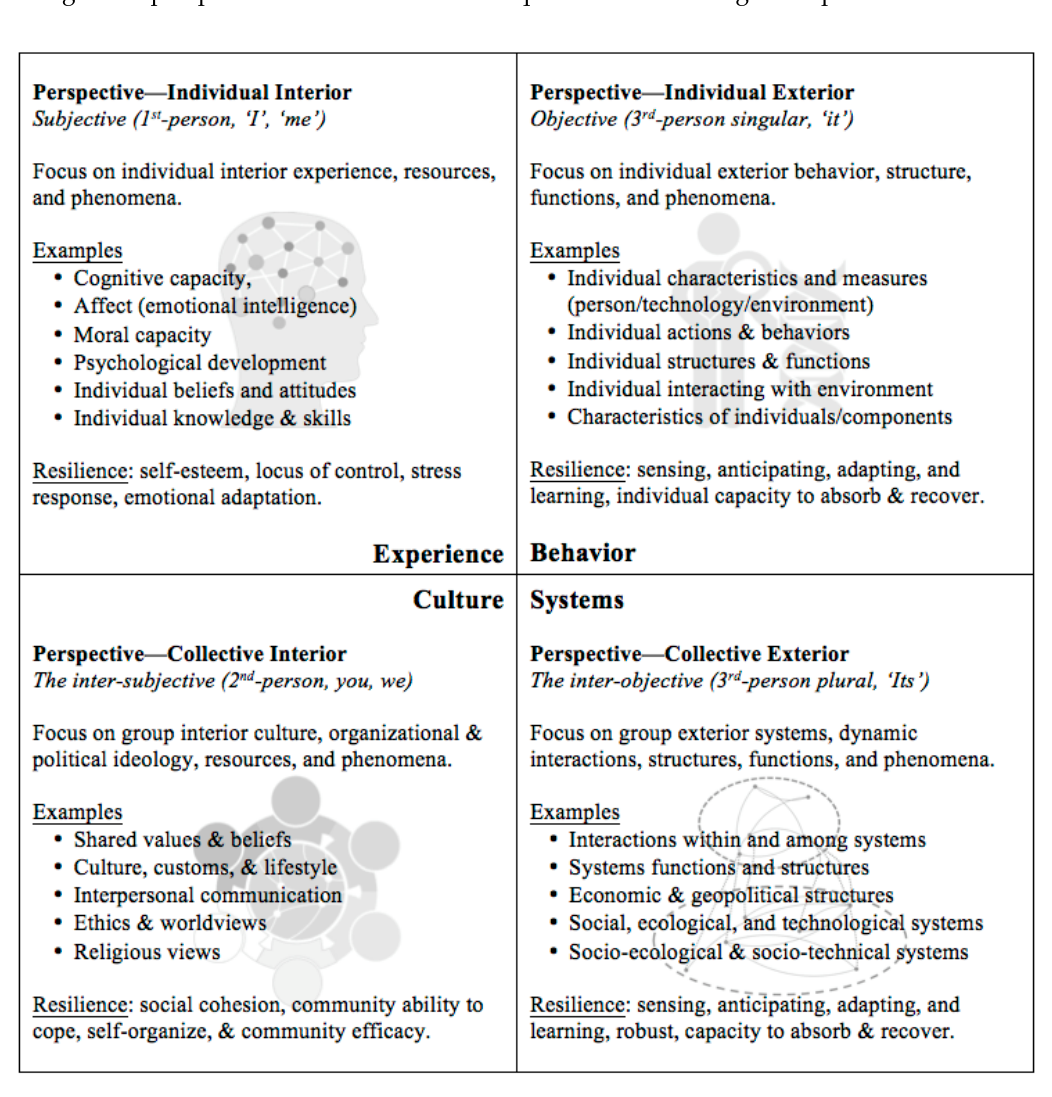
Figure 2. A heuristic representing each quadrant of the Integral Map with examples of different ways of knowing and resilience concepts.